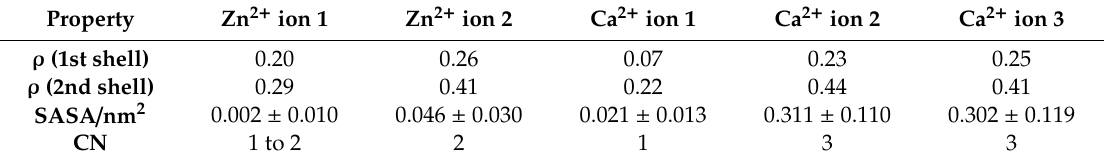
Table 4. Solvation properties of the associated divalent cations. SASA, solvent exposed surface area.